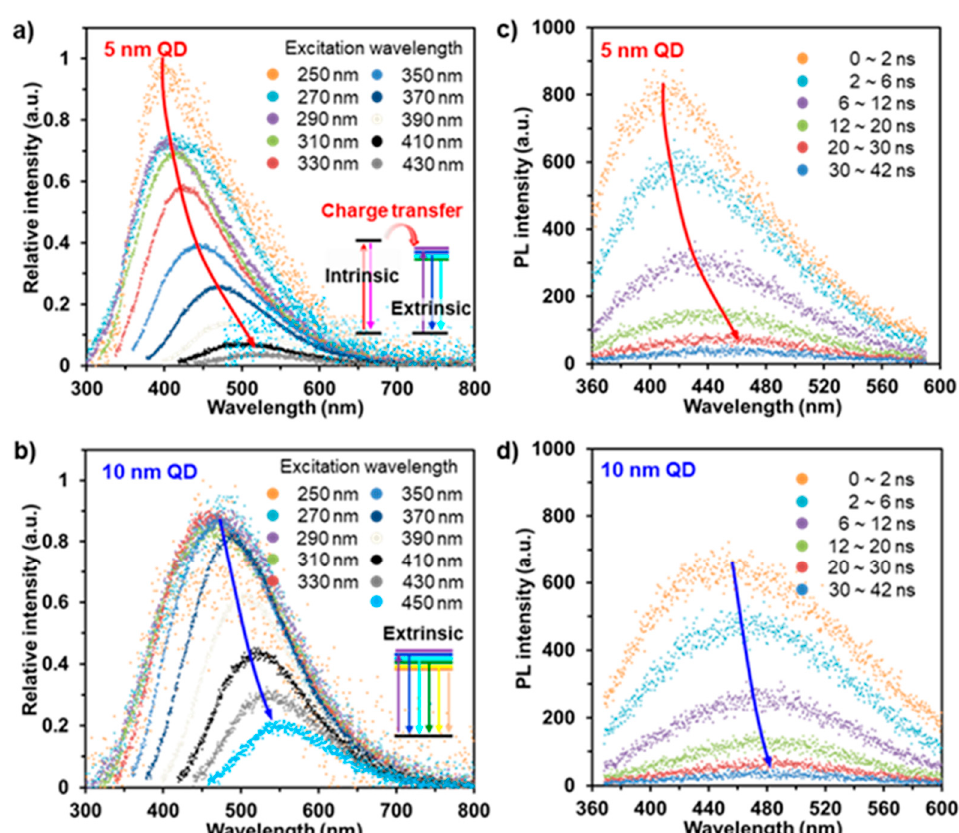
Figure 3. Optical characterizations of carrier dynamics in the 5 ‐ and 10 ‐ nanometer MoS 2 QDs. ( a , b ) PL spectra of the MoS 2 QDs with varying excitation wavelength. ( c , d ) Time ‐ resolved PL spectra of the MoS 2 QDs under excitation at 266 nm.